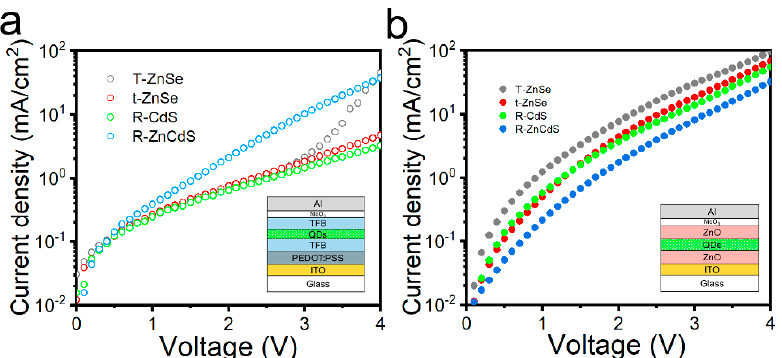
Figure 4. ( a ) Current density − voltage characteristics of hole-only and ( b ) electron-only devices of R − CdS, T − ZnSe, t − ZnSe and R − ZnCdS quantum dots. Inset: schematic diagram of device structure. R-CdS, T-ZnSe, t-ZnSe and R-ZnCdS quantum dots. Inset: schematic diagram of device